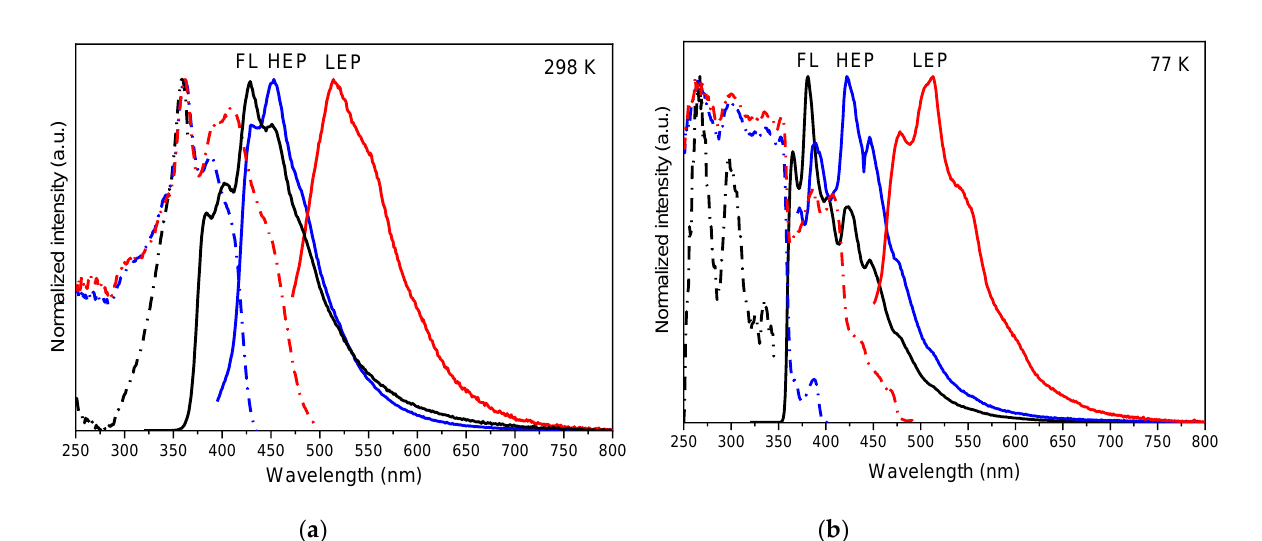
Figure 6. Normalized PL emission (continuous lines) and excitation (dashed–dotted lines) spectra of crystalline powders of TT-(HThio) 3 : ( a ) 298 K, emission at λ exc = 300 nm (black), 384 nm (blue), 450 nm (red), excitation at λ em = 382 nm (black), 452 nm (blue), 514 nm (red); ( b ) 77 K, emission at λ exc = 300 nm (black), 360 nm (blue), 430 nm (red), excitation at λ em = 365 nm (black), 423 nm (blue), 513 nm (red).